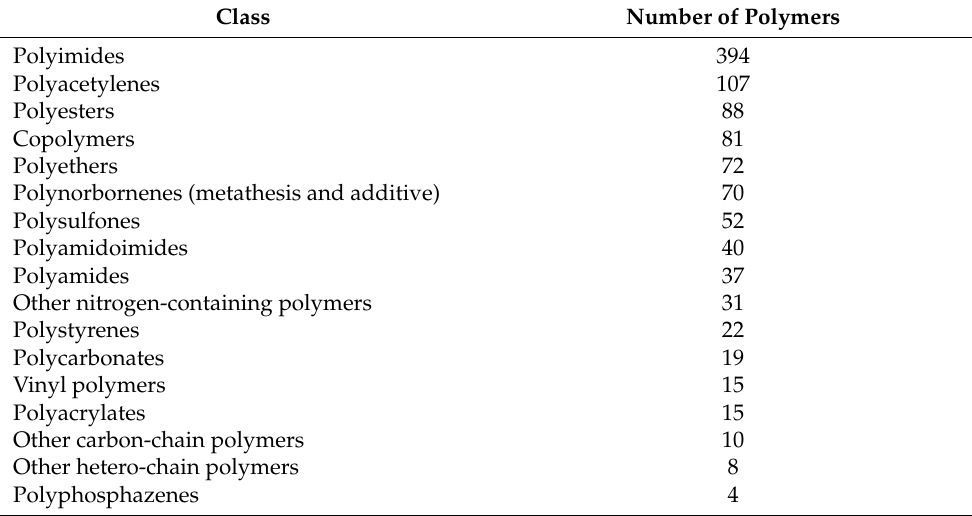
Table 1. Distribution of polymers throughout